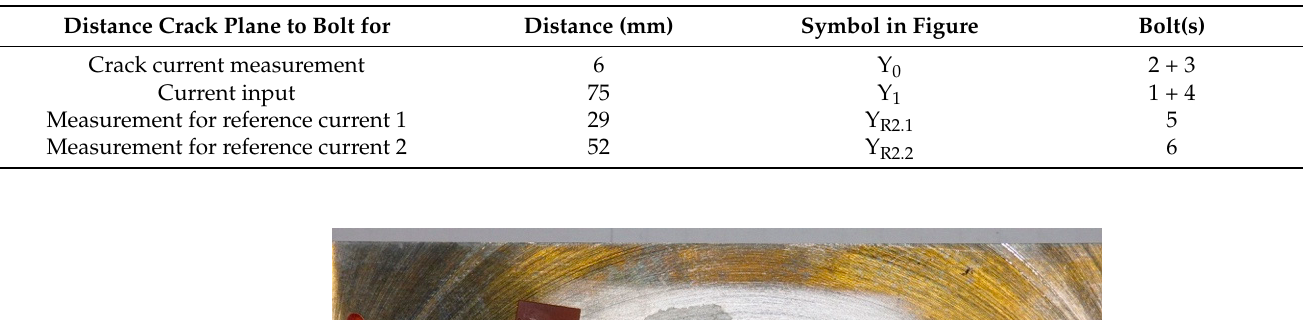
Figure 2. Positions of the welded bolts for current input and measurements. Table 3. Position of the bolts welded to the specimens for measuring signals and connecting the power supply.